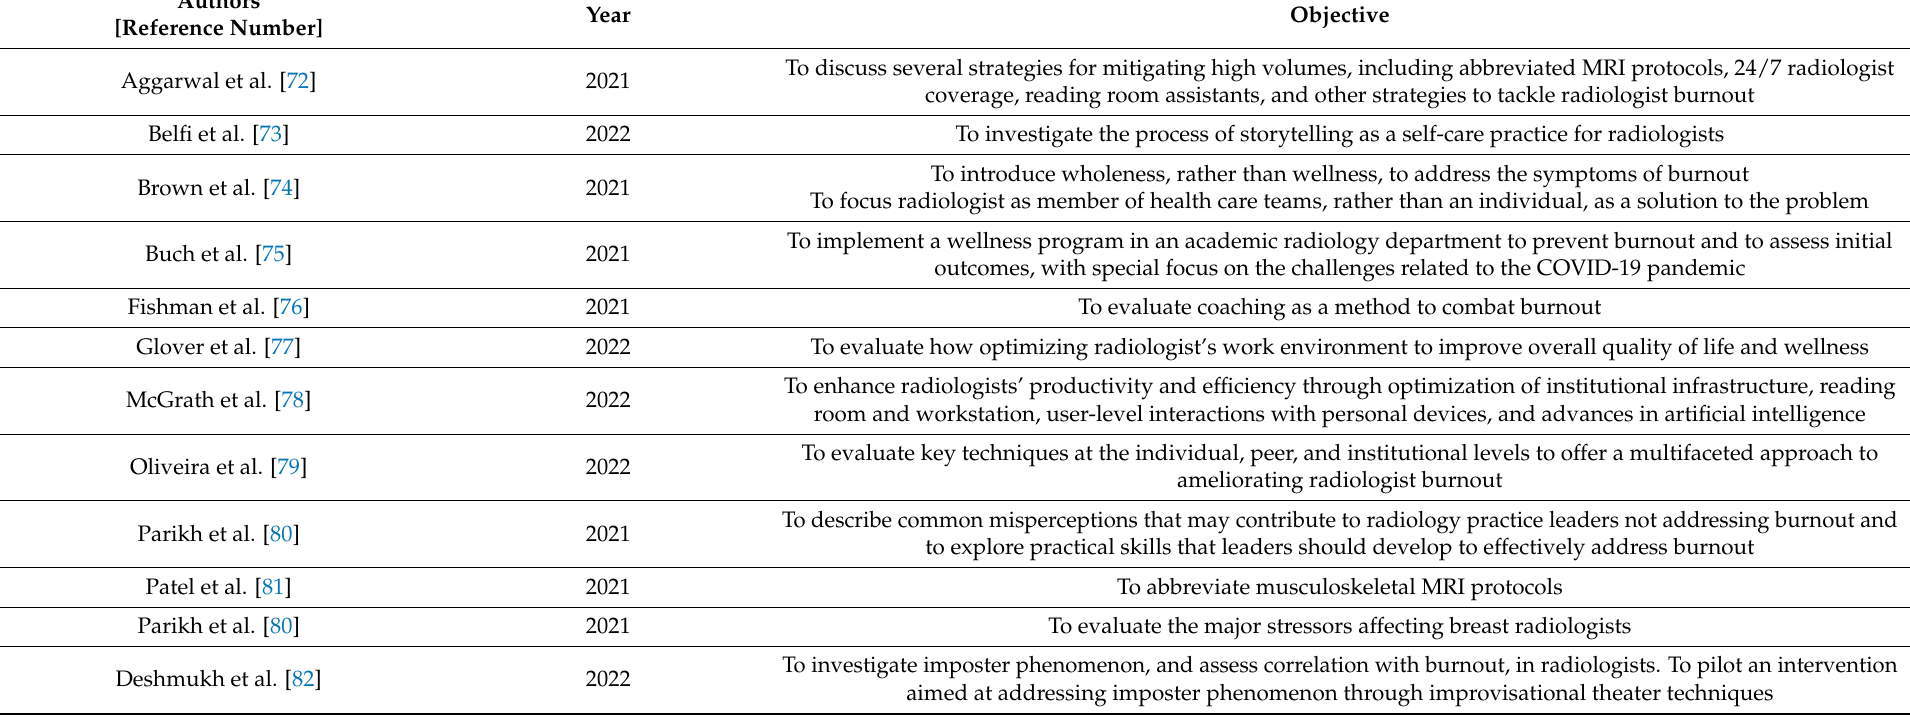
Table 2. Articles analyzed not based on